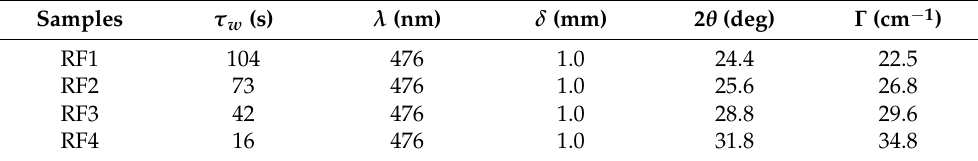
Table 2. Experimental results of two-wave coupling of exponential gain coefficient of Sc:Ru:Fe:LiNbO 3 crystal.